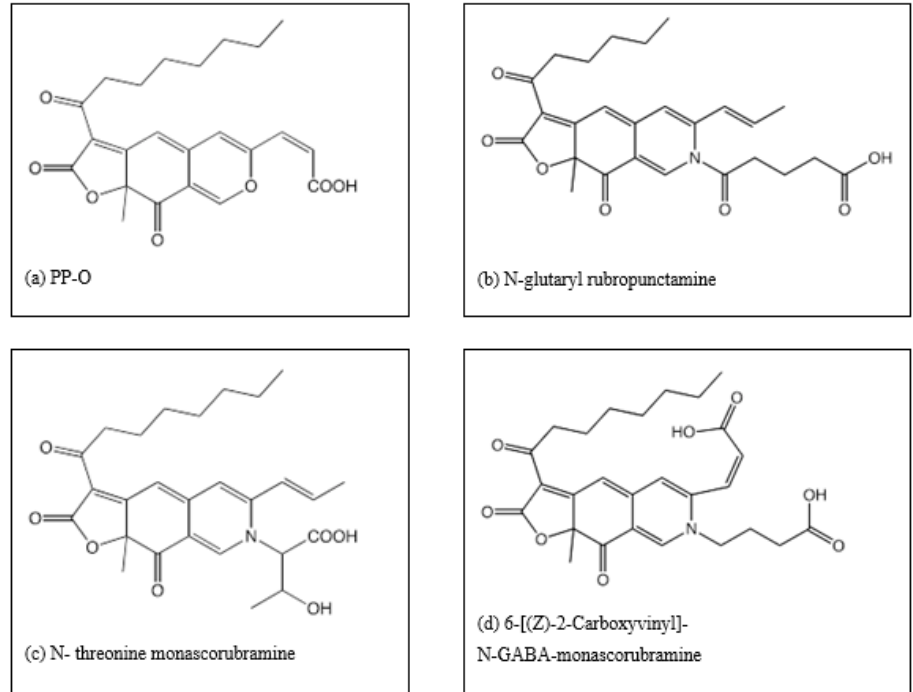
Figure 8. ( a – d ) Chemical structures identified in T. albobiverticillius 30548 cultured at 24 °C in potato dextrose broth without the addition of sea salts. ( a ) PP-O, ( b ) N-glutaryl rubropunctamine, ( c ) N- threonine monascorubramine, ( d ) 6-[(Z)-2-Carboxyvinyl]-N-GABA-monascorubramine (from reference [41]).